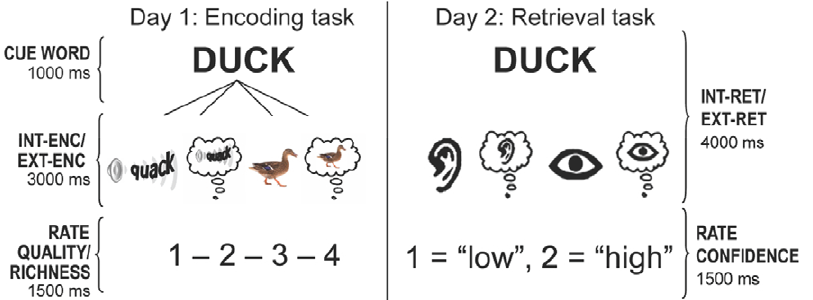
Figure 1. Experimental Task. Encoding trials consisted of three periods: a 1-second cue period, a 3-second encoding period, and a 1.5-second rating period. During the cue period, participants were introduced with a cue word together with an icon that indicated the trial condition. During the encoding phase, dependent on the icon, they either imagined an image or sound associated with the word (internally oriented conditions: Int- Enc) or they either perceived a sound or image associated with the word (externally oriented conditions: Ext-Enc). During the rating period, participants rated the imagery quality or perceptual richness of their experience. Retrieval trials, presented on the subsequent day, consisted of two periods, a 4-sec retrieval period, and a 1.5-sec confidence rating period. During the retrieval period, participants viewed the cue words from the previous day and retrieved the correct encoding source (1=imagined sound, 2=heard sound, 3=imagined image, 4=observed image). During the confidence rating period, they rated their confidence about their retrieval decision